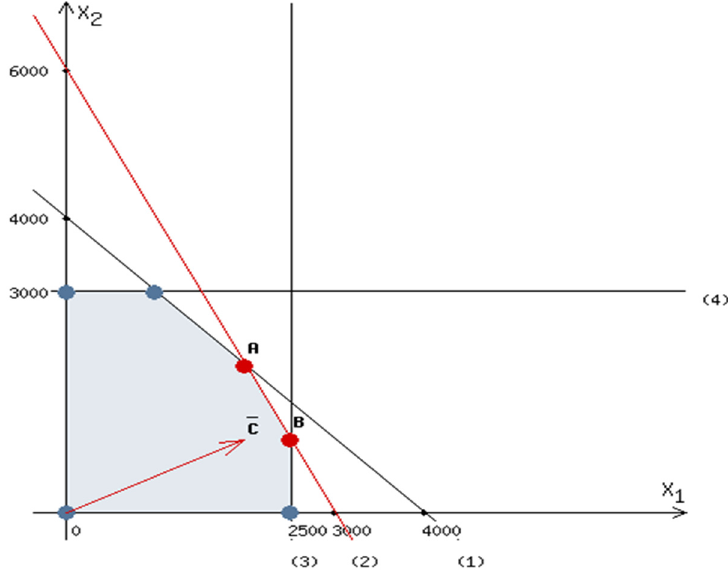
Figure 2. The function F that has a maximum value at any point on the line segment AB.